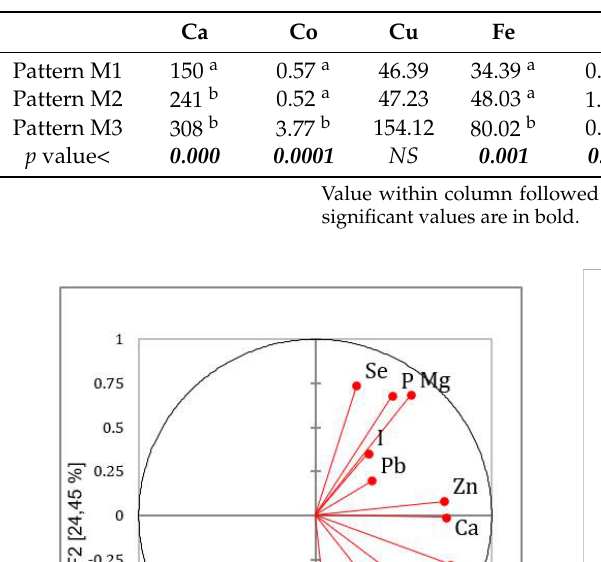
Table 11. Mean values of minerals in camel meat according to the patterns issued from Ascending Hierarchical Classification [ µ g/g wet weight].